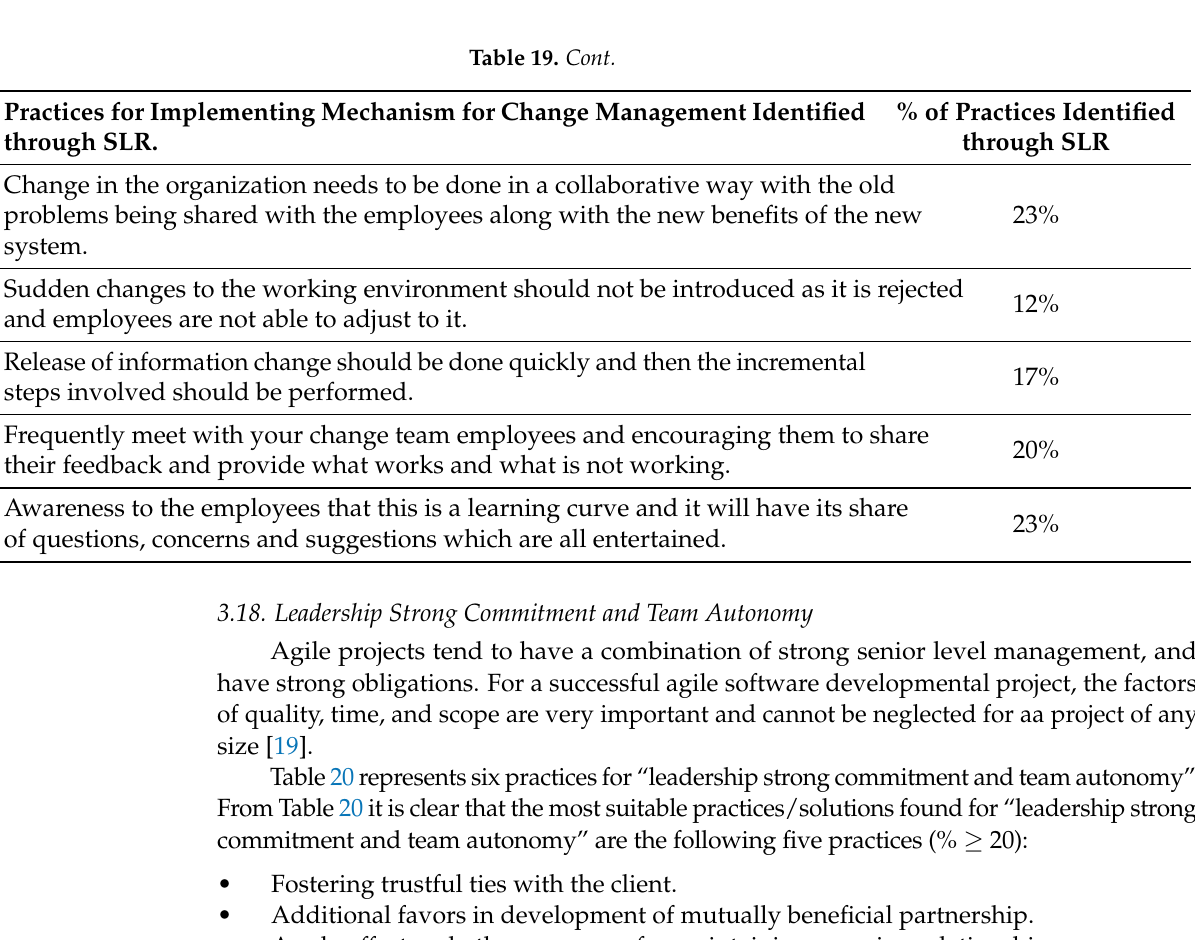
Table 20 represents six practices for “leadership strong commitment and team autonomy”.